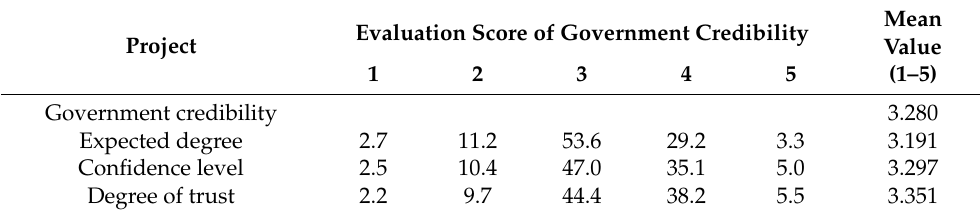
Table 10. Perception of government credibility